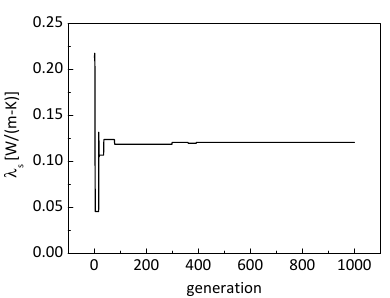
Figure 11. Evolution of the identified thermal conductivity of the nanometer-sized solid skeletons.